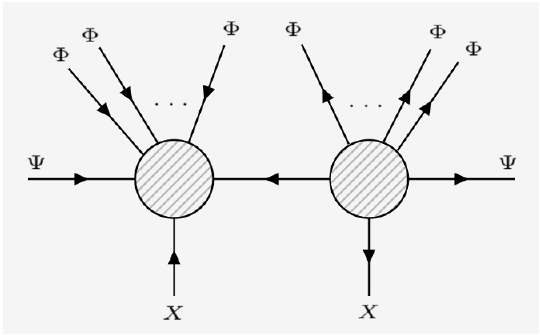
Figure 4 . Schematic contribution to the soft mass of a super(cid:12)eld (cid:9).